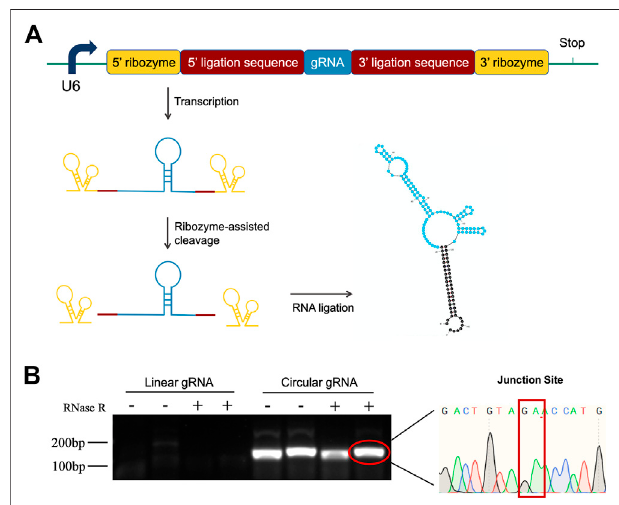
FIGURE1| ConstructiondesignandvalidationofcirculargRNA. (A) The gRNA sequence (blue) is fl anked by the 5 ′ - and 3 ′ ligation sequences (brick red). Each of them is linked with 5 ′ - and 3 ′ -self-cleaving ribozymes (yellow). After transcription, the autocleavage ribozymes generate a 2 ′ ,3 ′ -cyclic phosphate and 5 ′ -OH on the pre-circular RNA ends, which then were hybridized and formed the circular gRNA by the endogenous RtcB ligase. (B) Divergent primers were used to amplify both the circular and linear gRNAs, then the samples were subjected to RNase R digestion. Only the circular gRNA stayed and the product of gel extraction was sent for sequencing. The junction site of the circular hybridization was